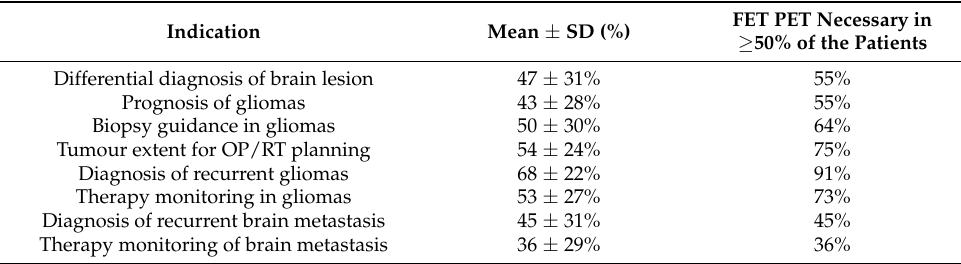
Table 2. Referrers’ rating of the percentage of patients in which FET PET is necessary for different